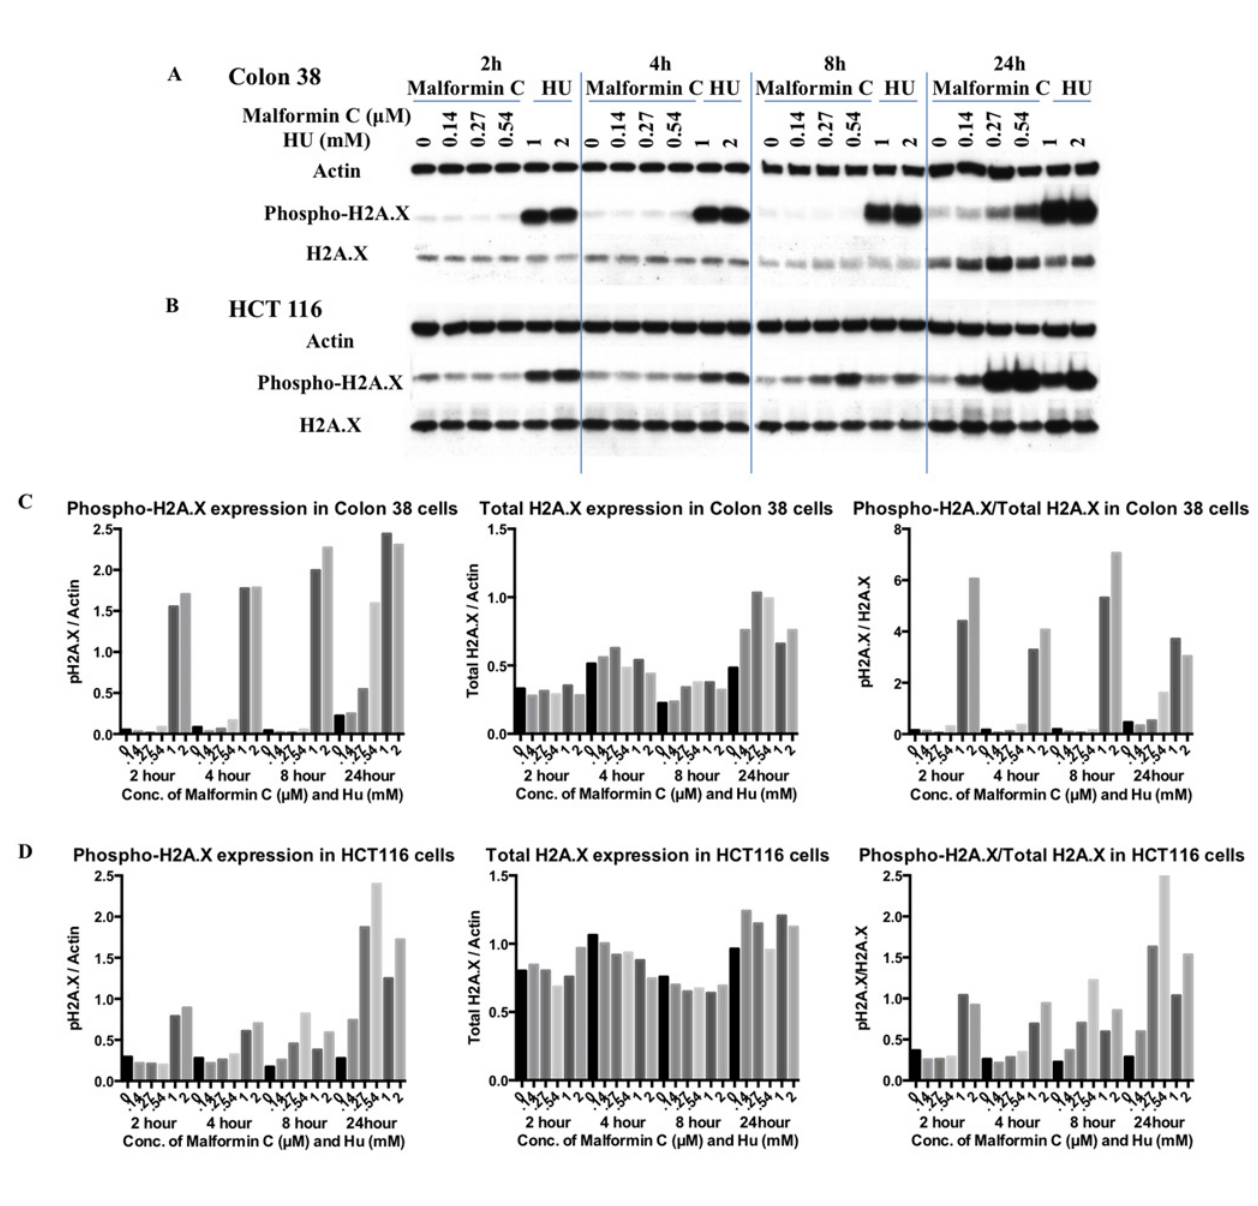
Fig 3. Expression of phosphorylated and total H2A.X in Colon 38 and HCT 116 cells treated with Malformin C. (A, C) The expression of phosphorylated and total H2A.X in Colon 38 cells treated with different concentrations of Malformin C (0 μ M, 0.14 μ M, 0.27 μ M, 0.54 μ M) and Hydroxyurea (1mM, 2mM) for 2-hour, 4 hours, 8 hours and 24 hours tested by Western blot, with β -Actin expression as an internal control. Hydroxyurea was used as positive control. H2A.X is phosphorylated at Ser139. (B, D) The expression of phosphorylated and total H2A.X in HCT116 cells treated with different concentrations of Malformin C (0 μ M, 0.14 μ M, 0.27 μ M, 0.54 μ M) and Hydroxyurea (1mM, 2mM) for 2 hours, 4 hours, 8 hours and 24 hours tested by Western blot, with β -Actin expression as an internal control. Hydroxyurea was used as positive control. H2A.X is phosphorylated at